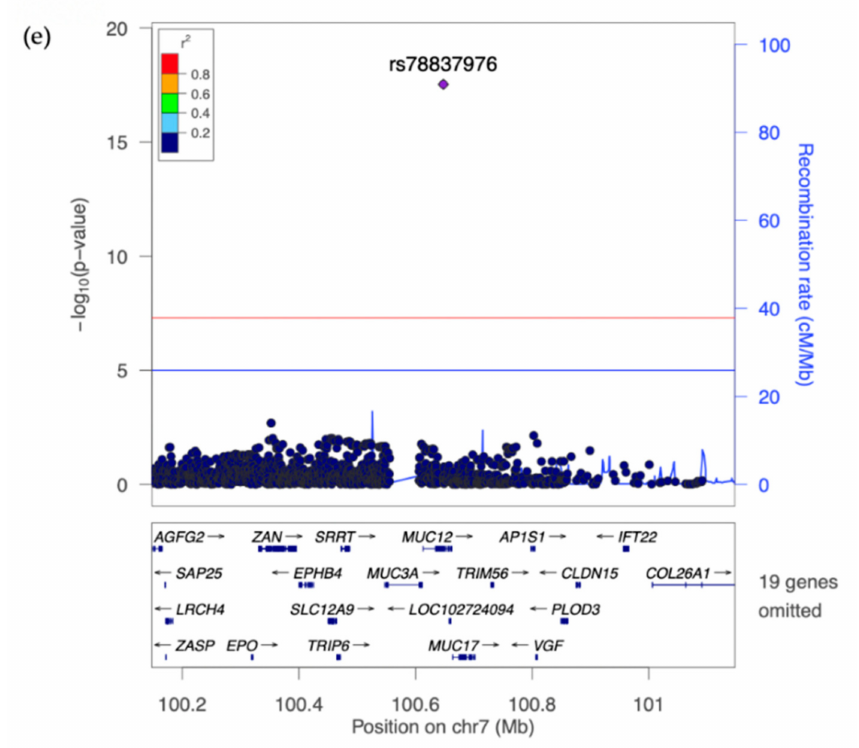
Figure 2. LocusZoom plots of novel genome-wide significant PD loci. ( a ) rs187989831 near TEKT4 on 2q11.1, ( b ) rs137887044 near WDR41 on 5q14.1, ( c ) rs74125032 in CARS2 on 13q34, ( d ) rs117672332 in ITGAE/HASPIN on 17p13.2, and ( e ) rs78837976 in MUC12 on 7q22.1. Association significance with PD is shown as − log 10 p -values on the left y -axis. The most significant SNP represented by purple colour diamond. All other SNPs are shown as circles and are colour coded according to the strength of LD with the most significant SNP (LD measured using the European 1000 Genomes